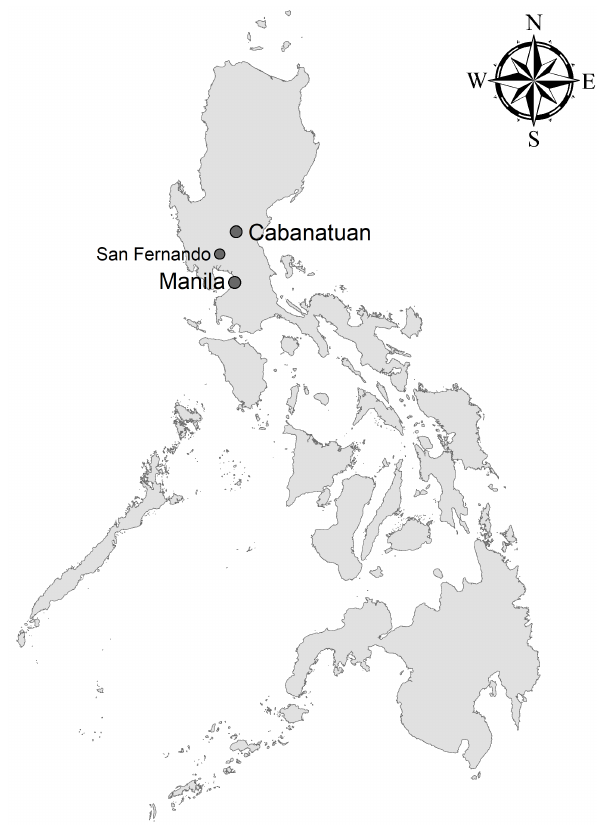
Figure 1. Map of the Philippines and location of Cabanatuan (with major